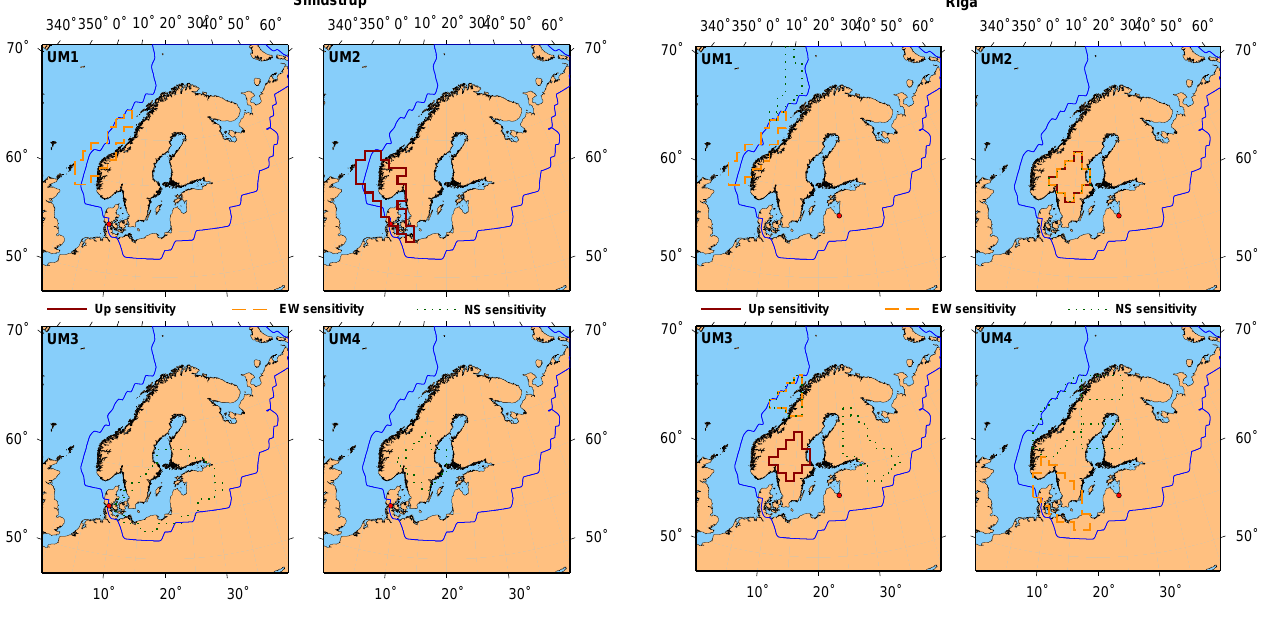
Fig.12. SameasFig.4,butforRiga. Figure 12. Same as Fig. 4, but for Riga.